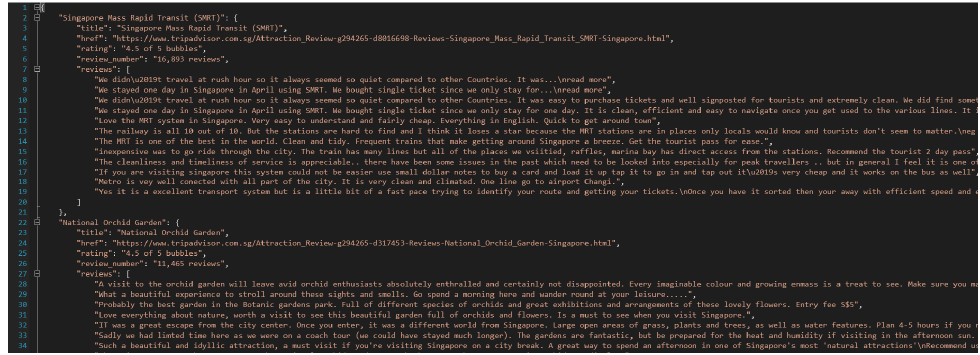
Figure 8. List of JSON files using Python programs to extract reviews from web portals.